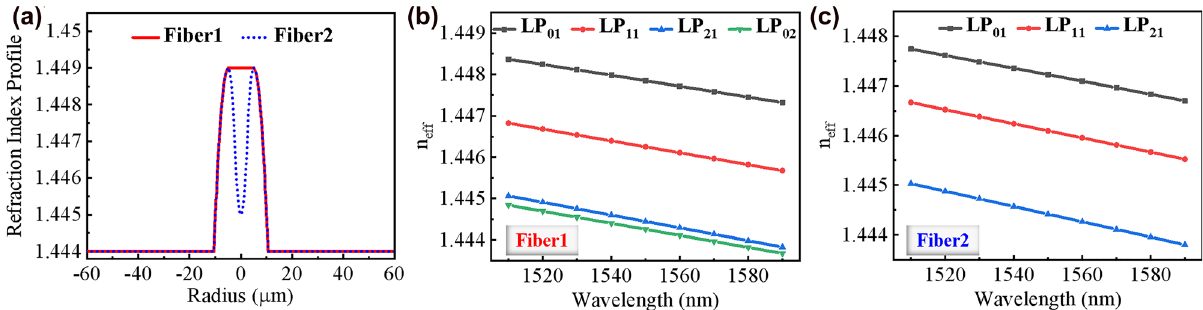
Figure 1: Optical fiber structural design and simulation. (a) RI profile of the designed fibers; calculated n